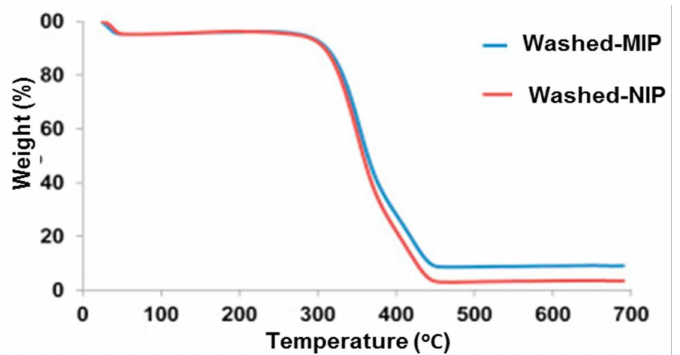
Figure 10. Thermogravimetric analysis of the synthesized polymers